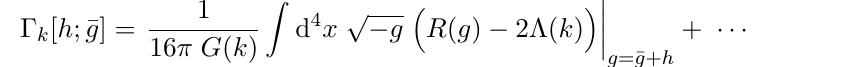
JHEP08(2022)040